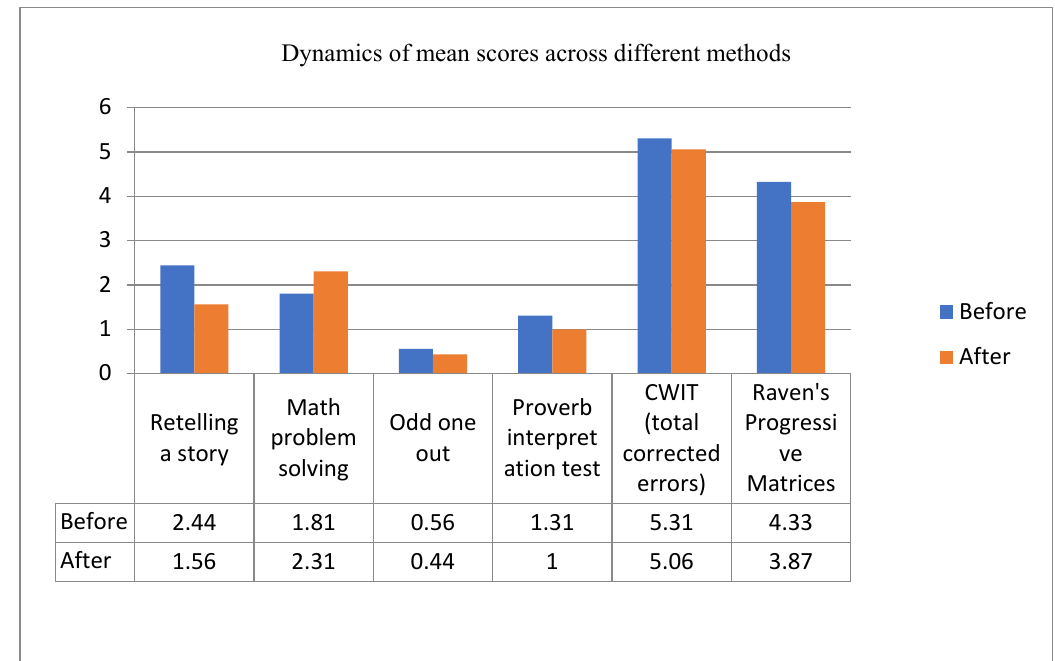
Figure 2. Dynamics of mean scores of methods which did not differ significantly before and after the training.